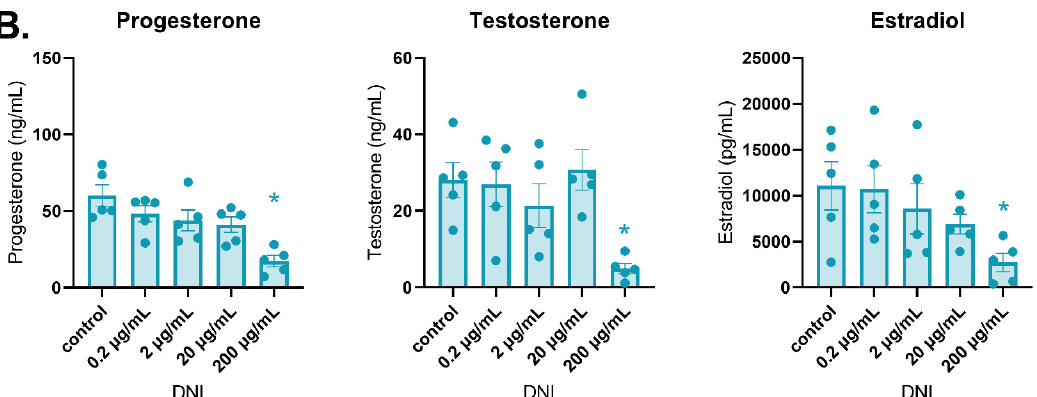
Figure 5. Effects of IMI ( A ) and DNI ( B ) on follicular sex steroid hormone levels after 96 h in culture. Antral follicles were treated with a vehicle (DMSO or water), IMI, or DNI (0.2–200 µg/mL) for 96 h. After the culture period, media from each treatment were pooled and subjected to ELISAs for testosterone, progesterone, and estradiol. The graphs indicate means ± SEMs from 3–5 separate